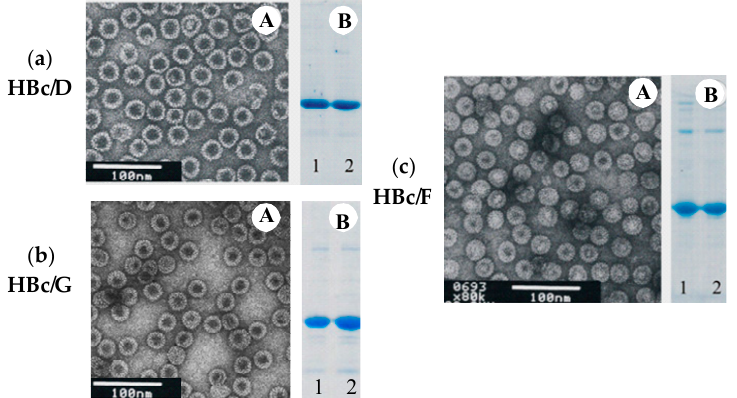
Figure 5. Analysis of the reassociated VLPs: HBc of genotype D ( a ), genotype G ( b ), and genotype F ( c ): A —electron microscopy of the reassociated VLPs; B —SDS-PAGE of the HBc dimers before reassociation ( 1 ), and SDS-PAGE of the VLPs after the reassociation ( 2 ). 3.3. Packaging of ds- and ssRNA into HBc VLPs for Genotypes D and G